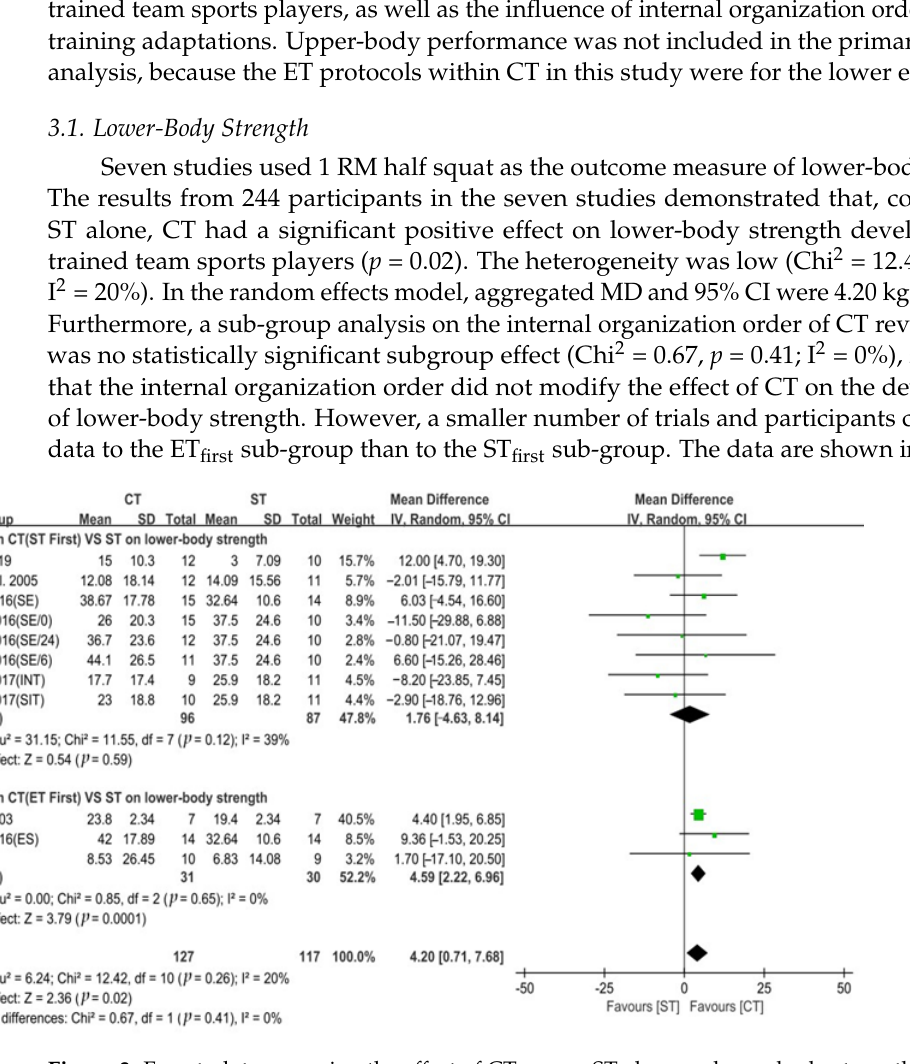
Figure 3. Forest plot comparing the effect of CT versus ST alone on lower-body strength [7,9,50 – 54].